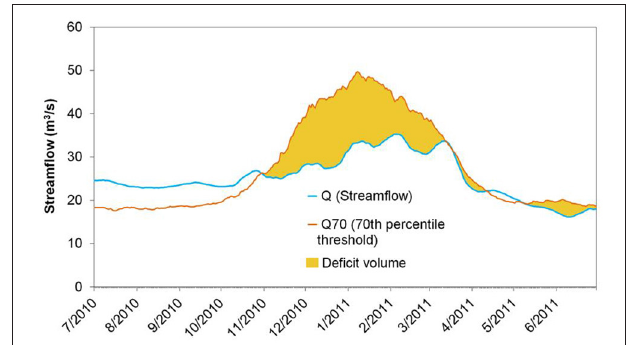
FIGURE 2 | Identification of hydrological drought conditions based on the daily varying threshold level Q 70 , using streamflow records from Atuel river during the period from July 2010 to June 2011. The data was smoothed by 15-day moving average. Hydrological drought conditions are observed when the observed daily streamflow records ( Q ) are lower than the Q 70 threshold, with the difference between the streamflow and the selected threshold quantifying the hydrological deficit (marked with orange color).